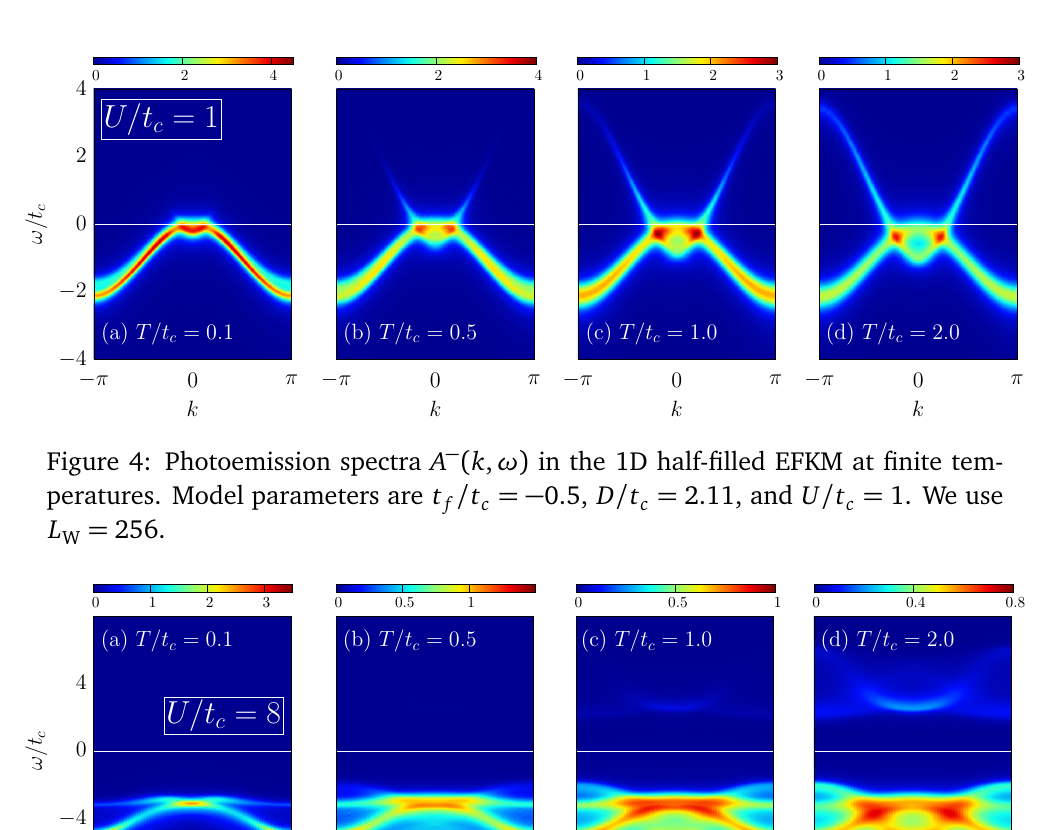
Figure 5: Finite-temperature PES A − ( k , ω ) in the strong-coupling regime of the 1D / t = − 0.5, D / t = 0.53, and U / t EFKM with t f c c = L W